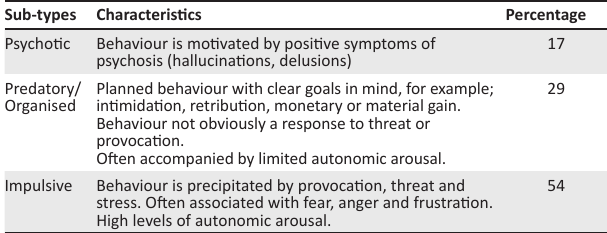
TABLE 5: Proportion of aggressive